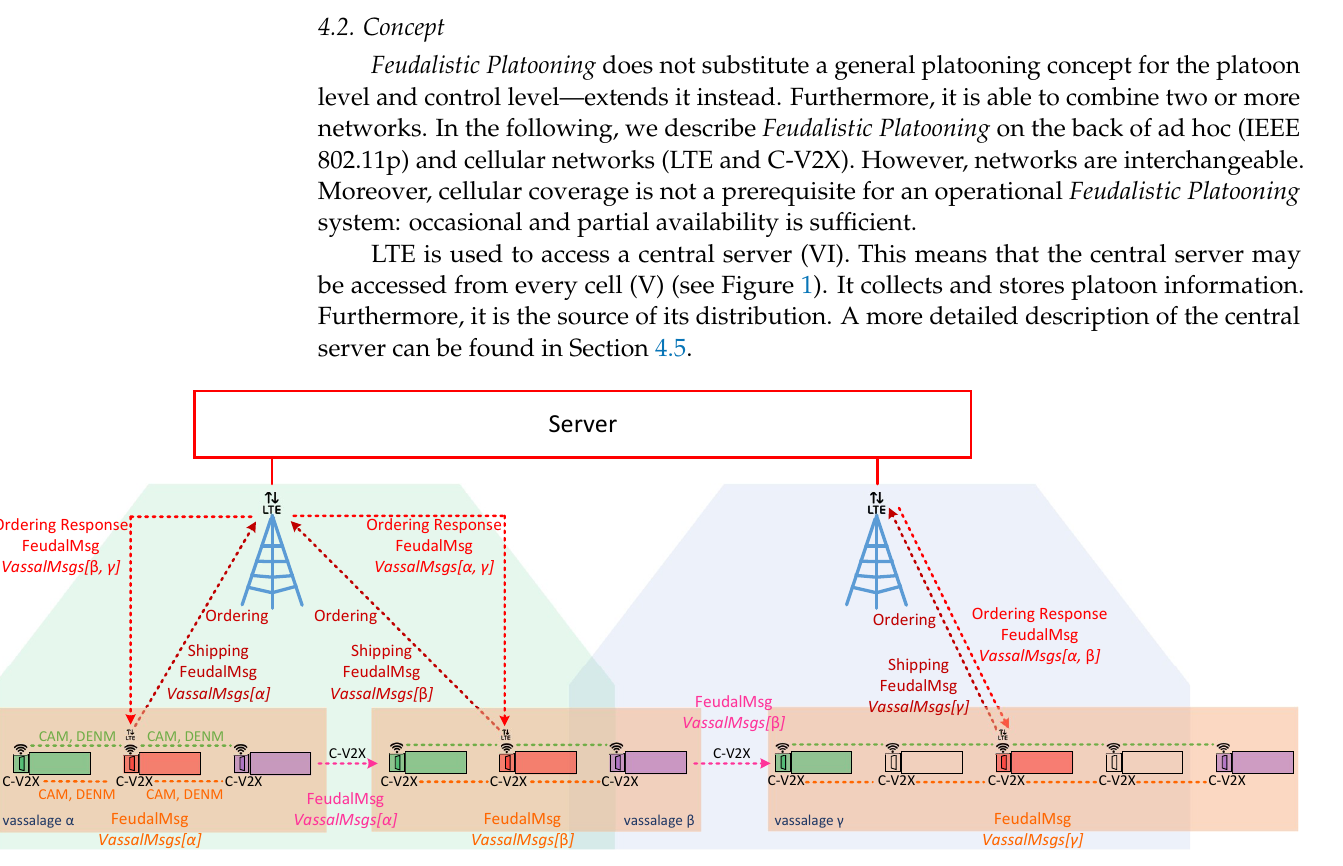
Figure 1. Feudalistic Platooning : Vehicle group as vassalages of variable size that act according to specific roles: knight (green); lord (red); merchant (purple); and peasant (no